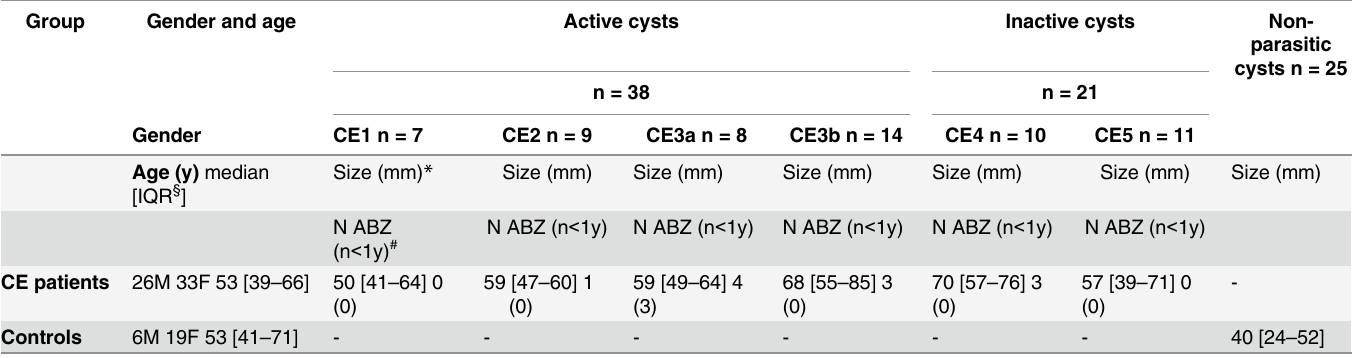
Table 1. Characteristics of patients and sera included in the